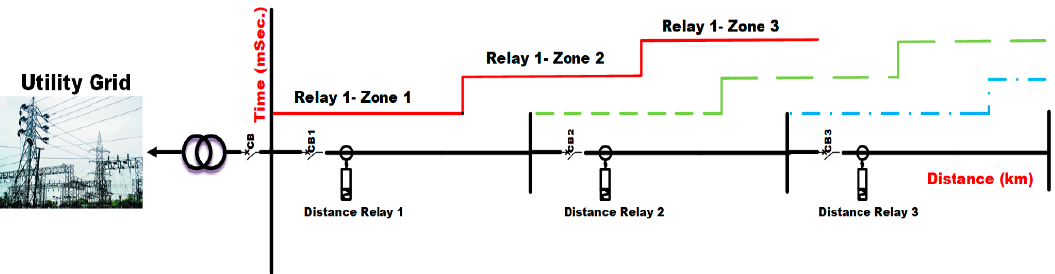
Figure 11. The zones of distance protective relays.